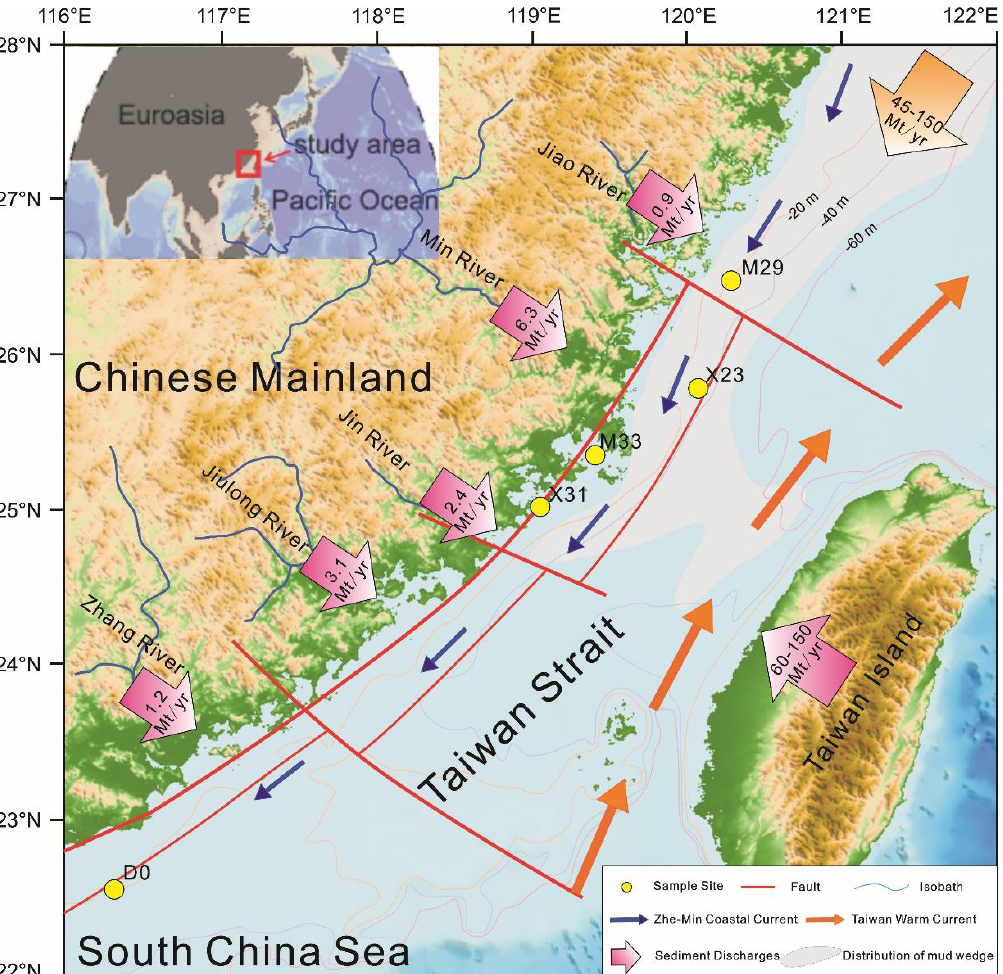
Figure 1. Location map and sampling stations of the study area. In this map, isobaths of 20, 40, and 60 m are shown by the thin light-yellow, purple, and red lines, respectively. Blue and orange arrows indicate the Zhe-Min Coastal Current and Taiwan Warm Current, respectively [48]. Arrows marked with gradual magenta and numbers indicate fluvial sediment discharge (Mt/year) from the Chinese mainland [29] and Taiwan. The mud wedge on the inner shelf of the East China Sea is marked with translucent gray areas. Fluvial drainage systems surrounding the TS (total sediment) and location of cores M29, X23, M33, X31, and D0 (yellow circle).